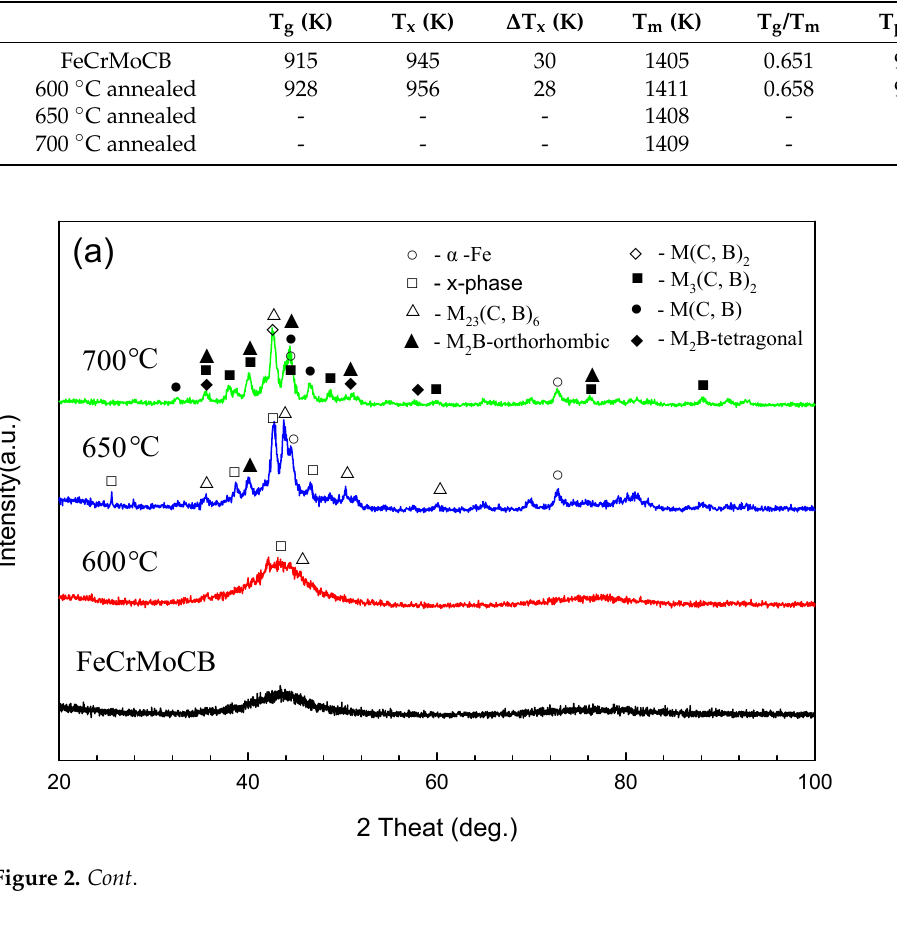
Figure 2. Measured results of the sprayed coating: ( a ) XRD spectrum, ( b ) DSC curves. Table 2. Related temperature parameters calculated from DSC curves. T g (K)